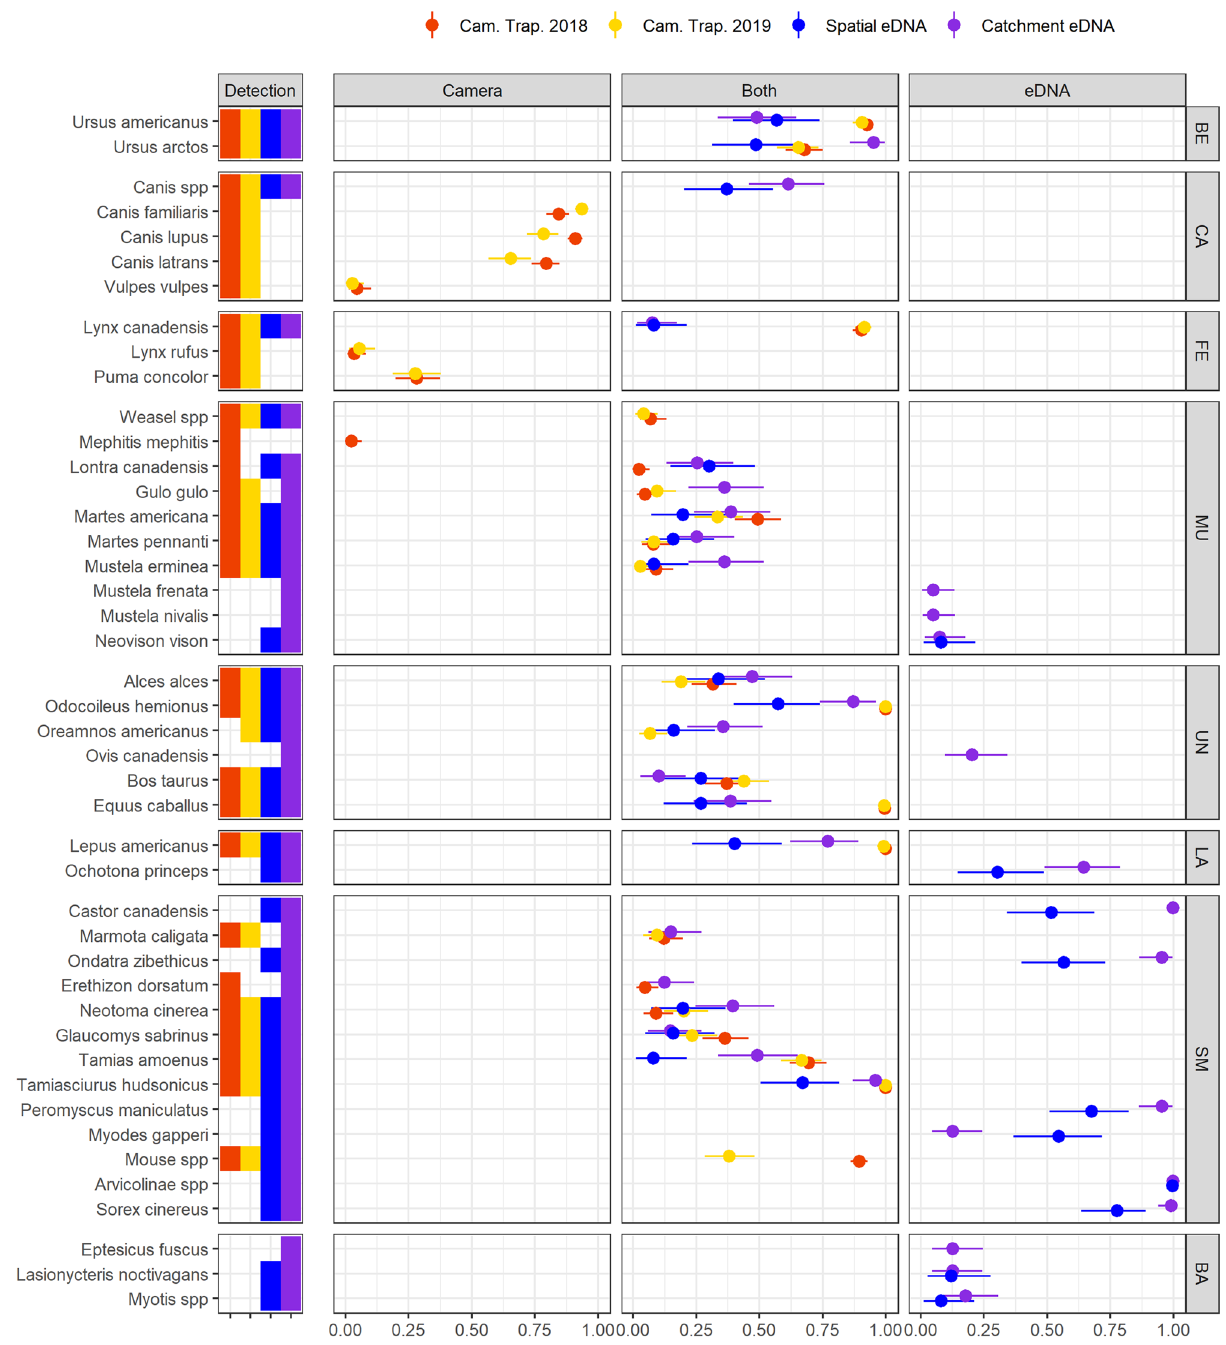
Figure 2. Overall species detection probabilities. To highlight the differences between methods, we divided the figure in three panels labelled “Camera”, “Both”, and “eDNA”. The left panel shows species detected via camera trapping only, the middle panel shows species detected by both camera trapping (red and yellow) and either eDNA sampling strategy (blue and purple), and the right panel shows species detected only by eDNA. The plain circles indicate the average detection probabilities for every species. The horizontal bars show the limit of the 95% Bayesian Credibility Interval. Scientific names of the taxa are on the left of the panel. Taxa are grouped by higher taxonomic level, which code is displayed on the right of the figure: BE for Bears, CA for canids, FE for felids, UN for ungulates, LA for lagomorphs, SM for small mammals, and BA for bats. The figure does not include 3 additional species ( Rangifer tarandus , Mus musculus and Felis spp) each detected in at least one eDNA sample, but which detection might result from contamination (see supplementary Tables